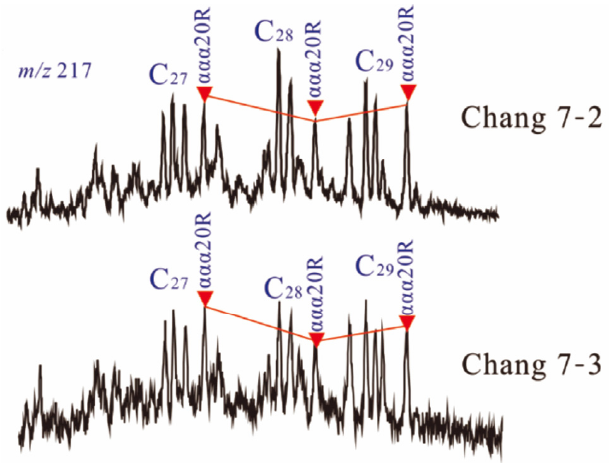
Figure 9. The distribution of regular steranes for partial Chang 7-2 and Chang 7-3 source